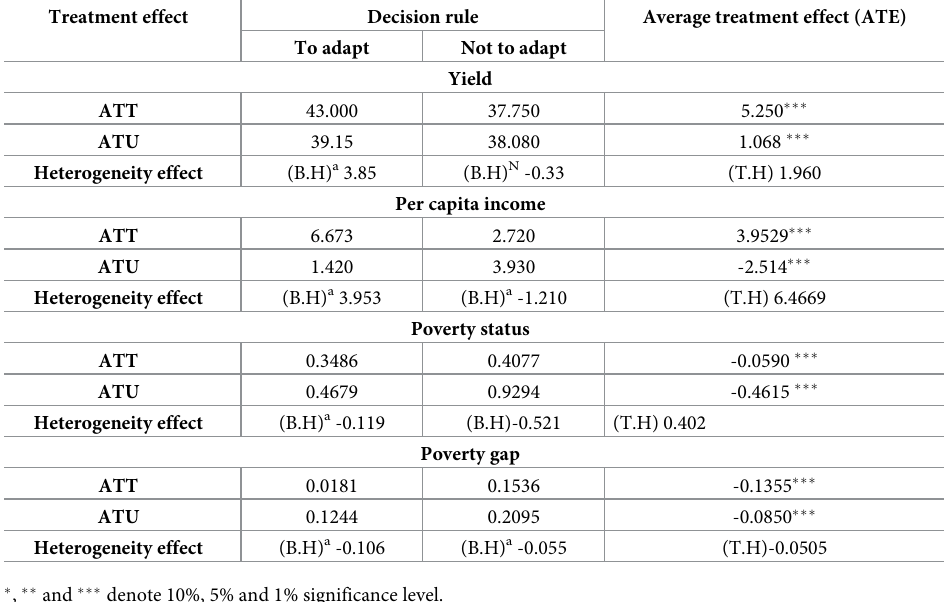
Table 6. Conditional expectation